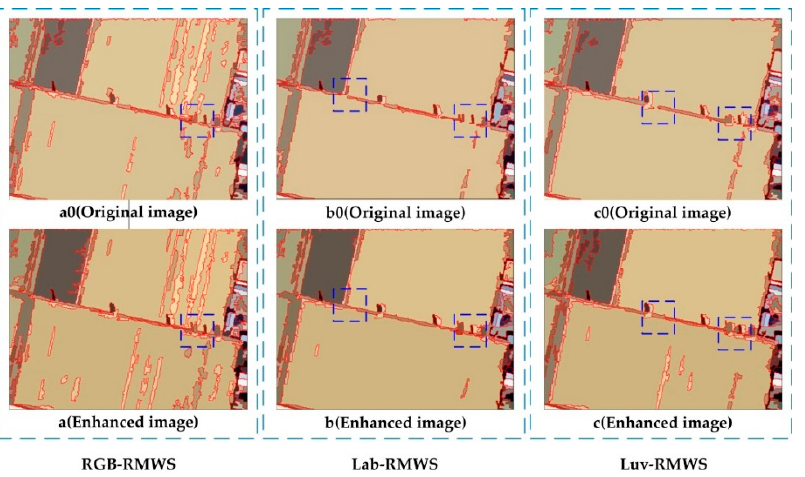
Figure 5. Comparison of segmentation results between the pre- and post-contrast-enhanced im- ages.